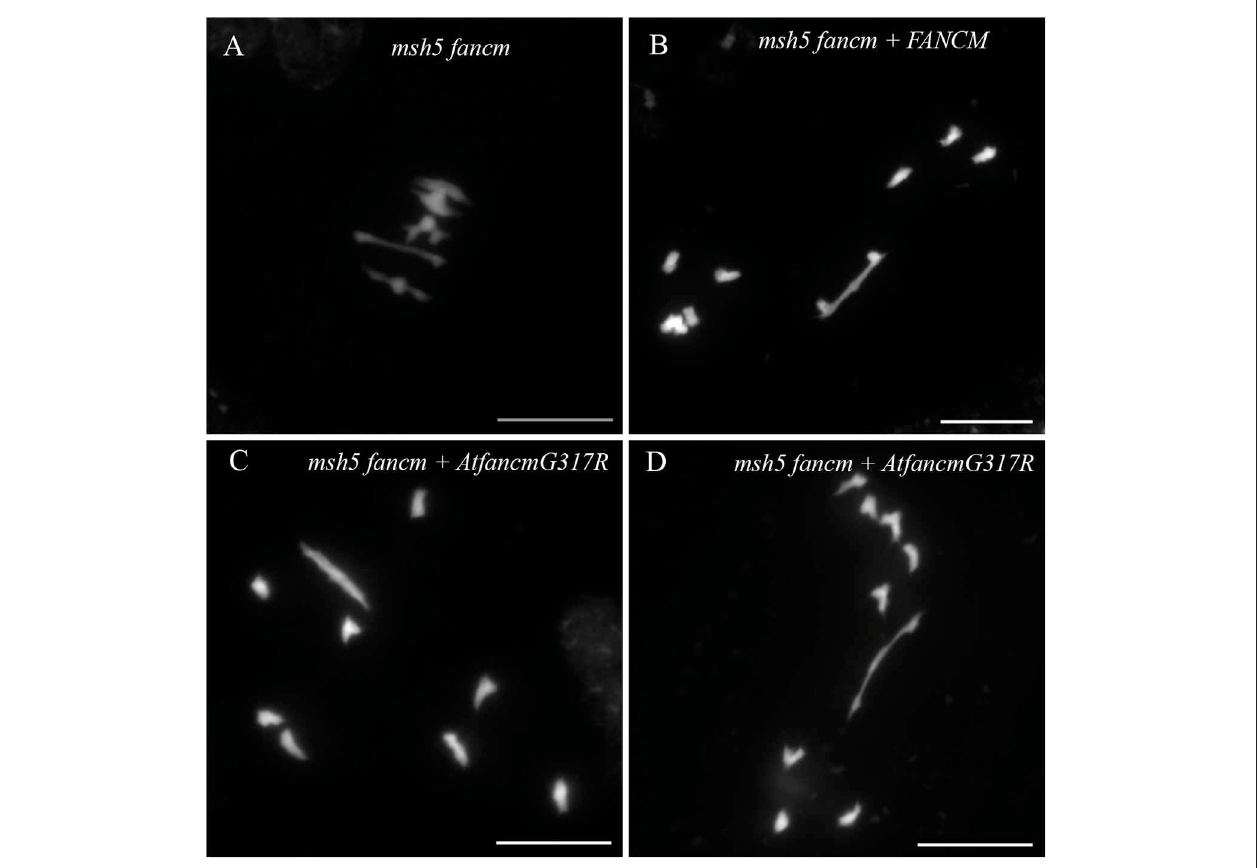
FIGURE 4 | Bivalent formation in A. thaliana msh5 fancm double-mutant transformed with different version of FANCM. During metaphase I, 5 bivalents were observed in msh5 fancm double-mutant meiocytes (A) . When complementing msh5 fancm with the WT allele of At_FANCM (B) , or with a modified copy of FANCM ( AtfancmG317R ) mimicking BnaC.fancm-2 (C,D) , mainly univalents were observed. Scale bar = 10 µ m.